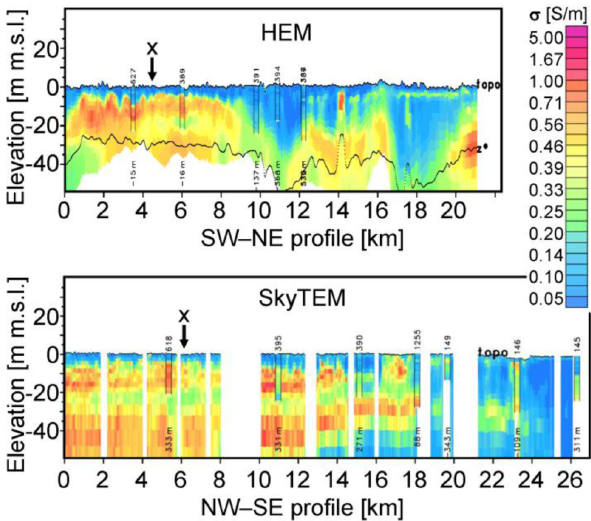
Fig. 11. Cross sections showing the EC for HEM (upper figure, cross section B-B’) and SkyTEM (lower figure, cross section A-A’) inversions with a-priori constraints of ECPTs. For location of cross sections, see Fig. 1. The black line in the upper figure denotes the centroid depth values ( Z ∗ ), indicating the depth of investigation.